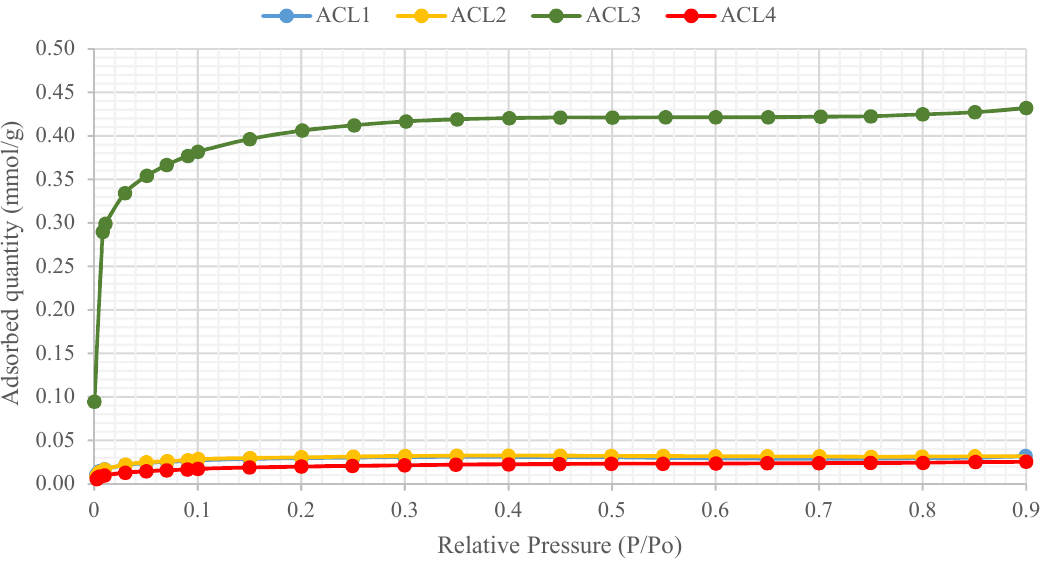
Figure 3. N 2 adsorption isotherms of ACL.